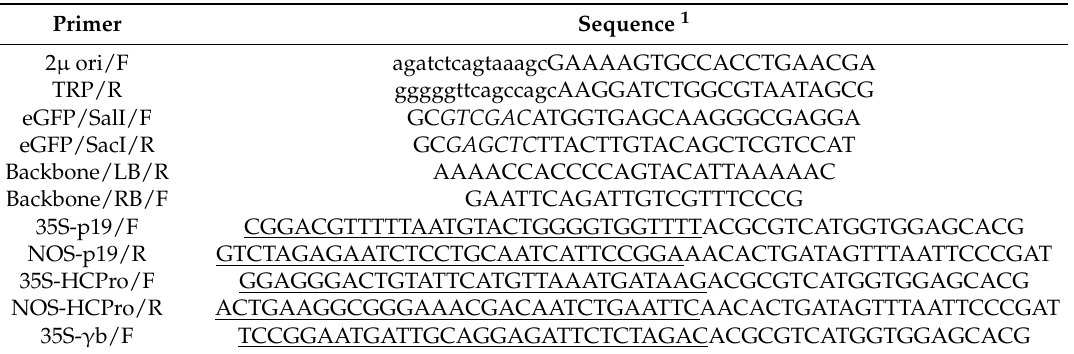
Table A1. List of primers used in the